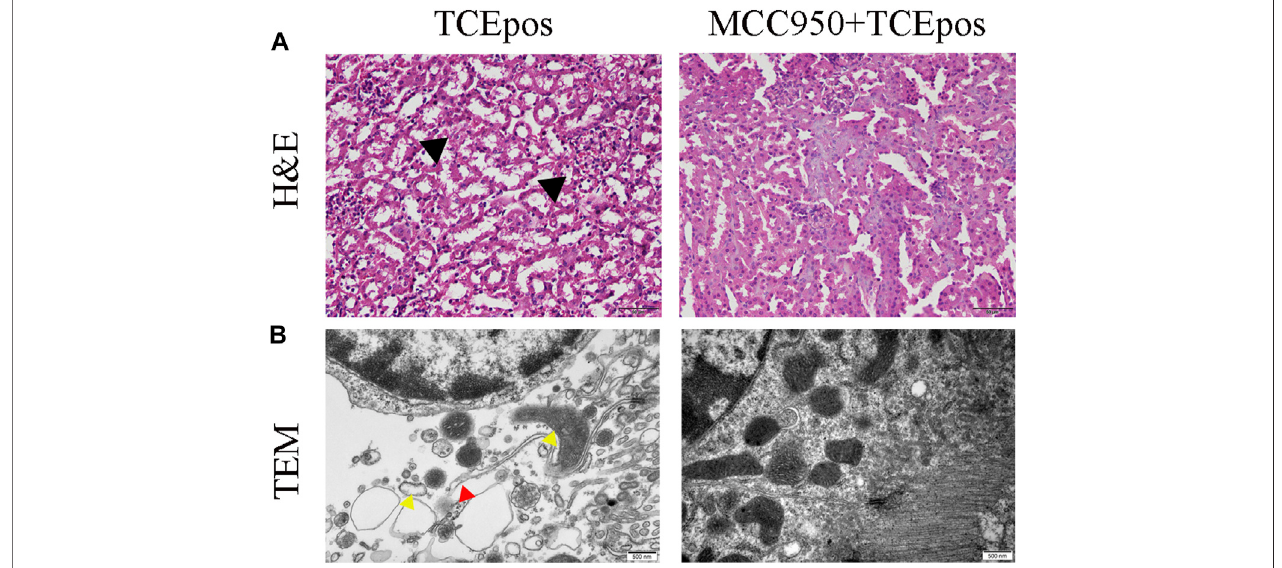
FIGURE6| MCC950pretreatmentamelioratedthestructuralchangesofrenaltubulesandRTECsinmice. (A) H&Estainingofmousekidney(magni fi cation,×400). Theblackarrowshowstubularswelling,vacuolardegeneration,ordetachmentofrenaltubularepithelialcells.Thescalebarsrepresent50 μ m. (B) Transmissionelectron microscopy(TEM)ofRTECs(magni fi cation, ×30000).Thered arrowshowstherupturedcytomembraneandtheyellow arrowshowsmitochondrial edemaandvacuolar degeneration. The scale bars represent 500 nm. Data are representative images from three mice or independent experiments ( n =